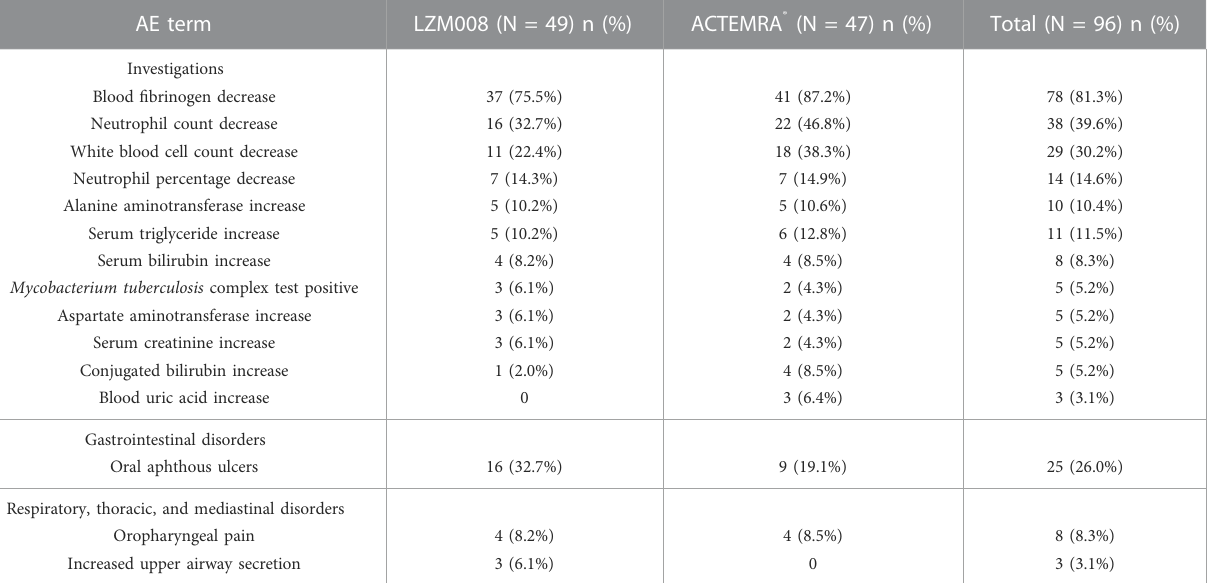
TABLE 4 Drug-related TEAEs of LZM008 and ACTEMRA ®